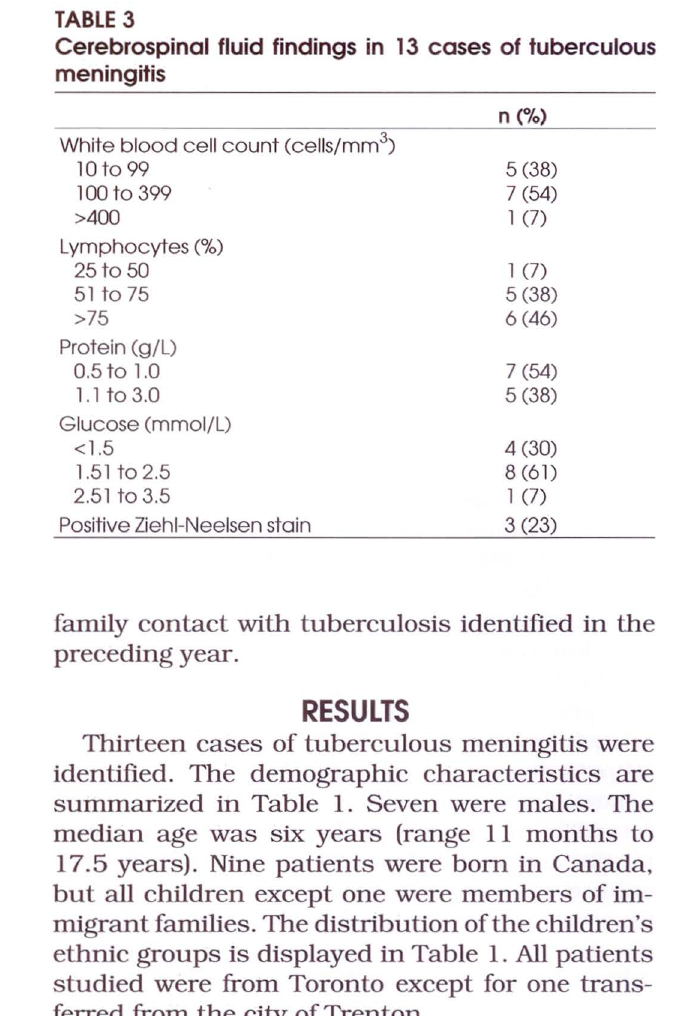
tuberculous meningitis